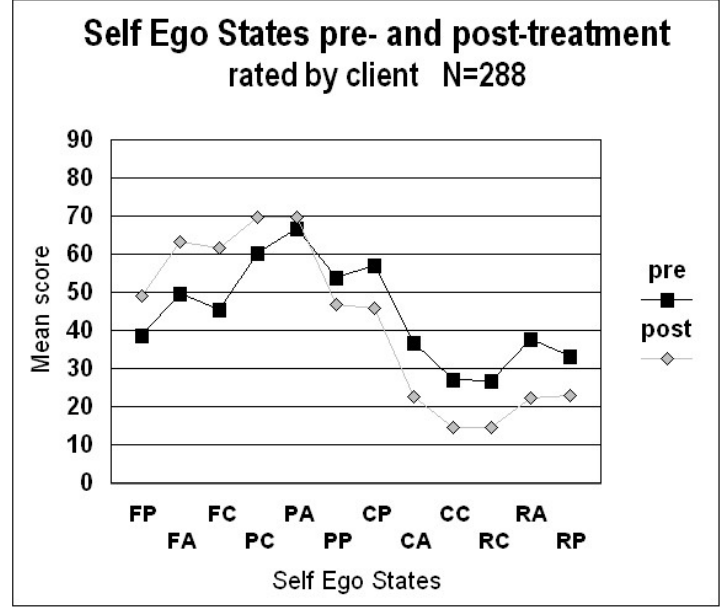
Figure 2: Profiles of the means of Self Ego state pre- and